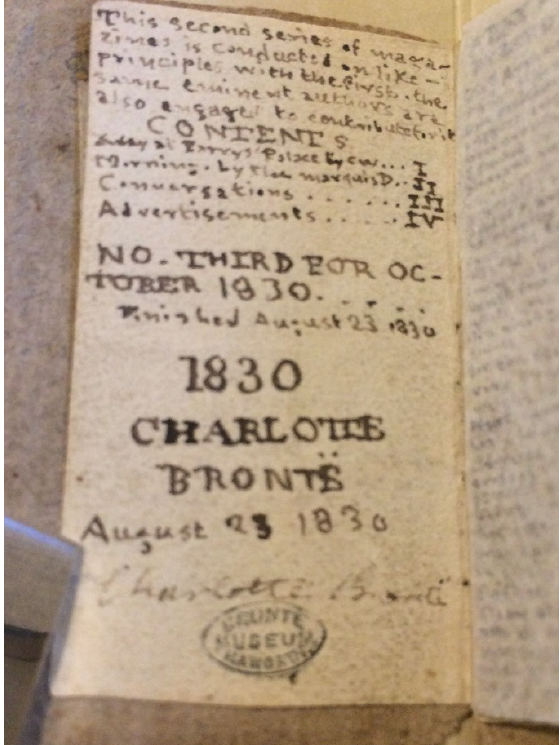
Figure 3. The table of contents of the October 1830 Young Men’s Magazine.